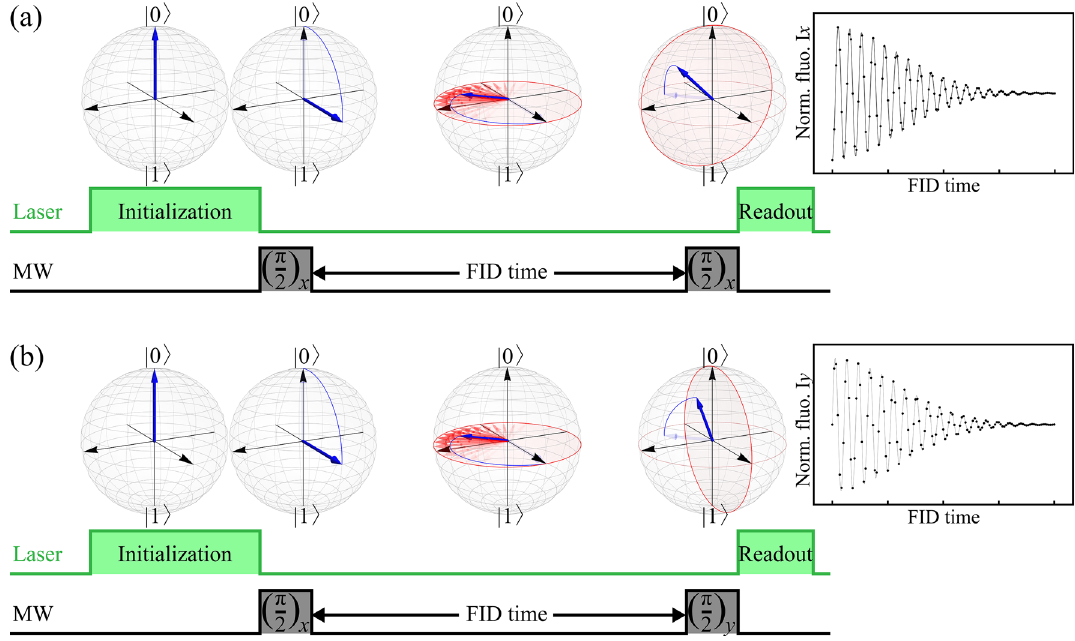
Figure 5. The proposed experimental realization is composed of two FID signals. ( a ) After the electron spin 0 initialization to by a 532-nm green laser, the standard Ramsey pulse sequence consists of two MW (π/ 2 ) x | � pulses separated by an FID time period, during which the spin qubit pure dephasing takes place. The final laser 0 is used to detect the remaining population in the state and the normalized fluorescence I x ( t ) is recorded. ( b ) | � To completely reconstruct the phase information, we need to measure the signal along the other orthogonal axis. A variation of the standard Ramsey pulse sequence is adopted by replacing the second MW pulse with (π/ 2 ) y and the signal I y ( t ) is recorded. Then the dephasing factor φ( t ) and the CHER ℘(ω) can be determined